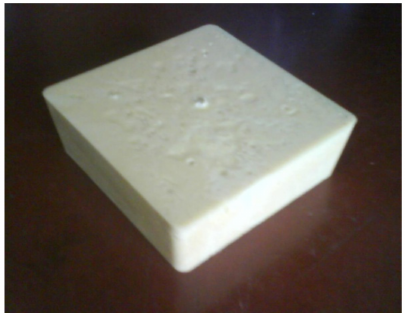
Figure 1. A rigid PU foams’ block, molded in a sealed steel mould.